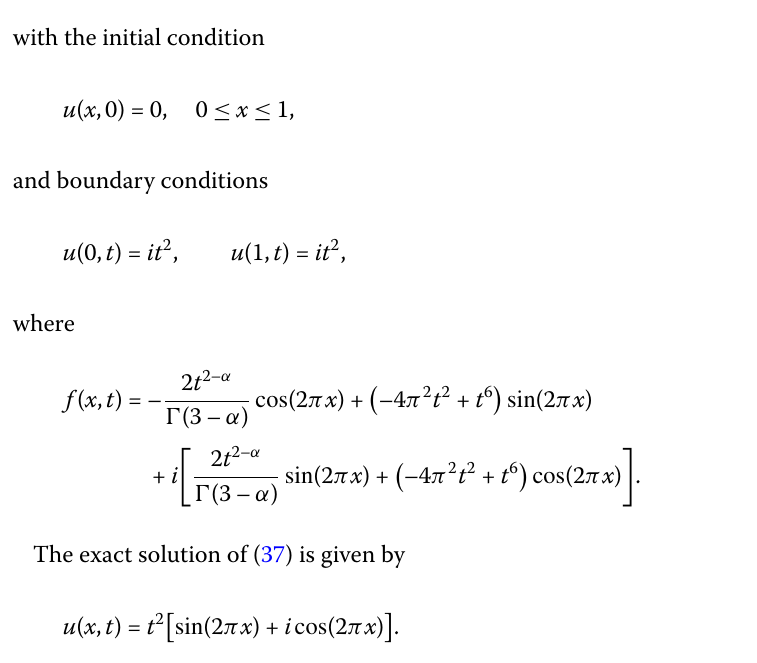
Table 1 The temporal errors and convergence orders with h = 1